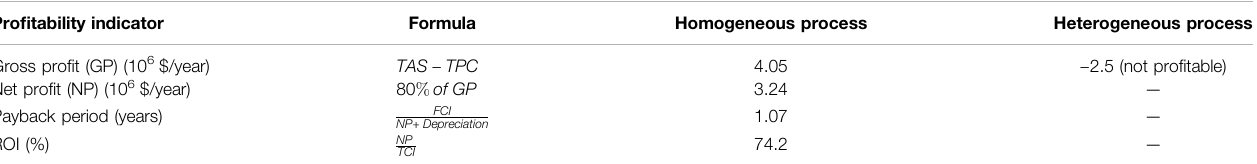
TABLE 5 | Pro fi tability indicators for homogeneous and heterogeneous processes. Pro fi tability